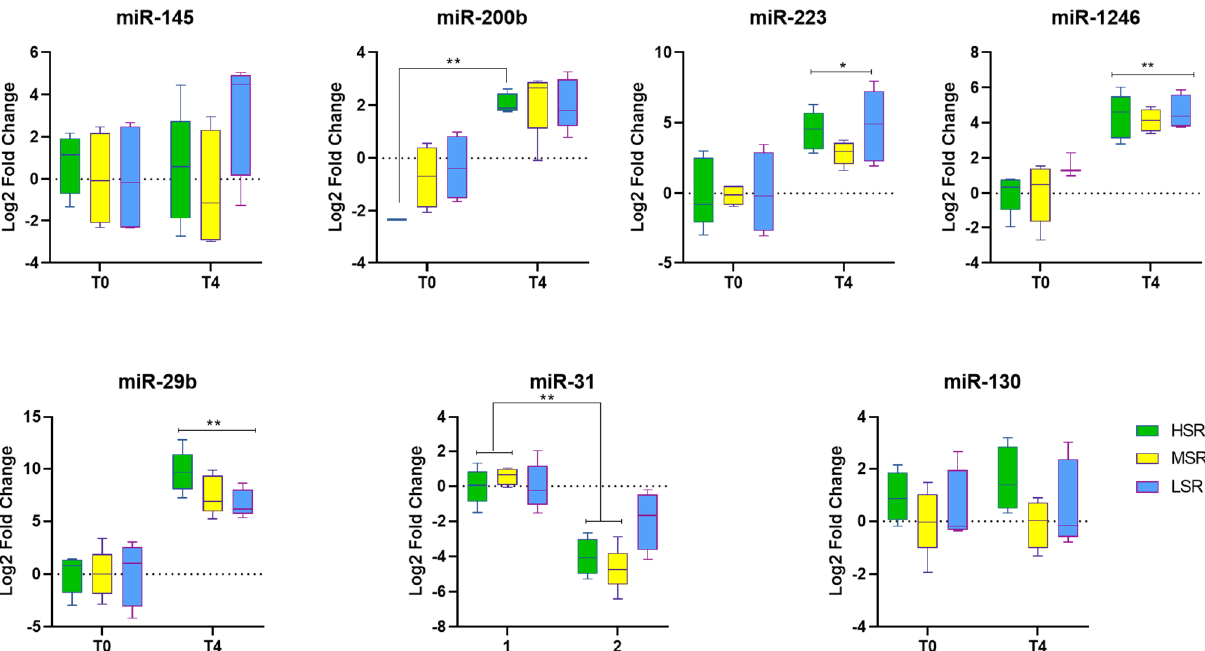
Figure 2. Fold change in expression of candidate ovine microRNAs (miR-145, miR-200b, miR-233, miR-1246, miR-29b, miR-31, and miR-130) before (T0) and 4 h (T4) after LPS (400 ng/kg) i.v. administration. The asterisks (* p ≤ 0.05 and ** p ≤ 0.01) indicate significant differences between T0 and T4.